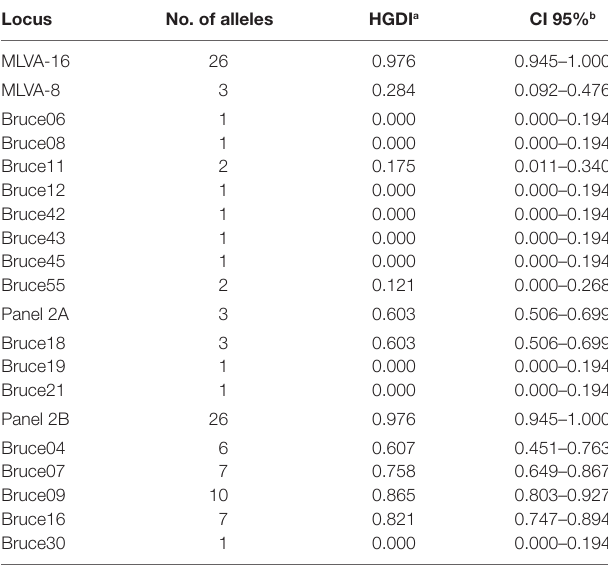
TaBle 1 | Hunter-Gaston Diversity Index (HGDI) for the 32 Chinese Brucella canis isolates. locus no. of alleles hgDi a ci 95% b